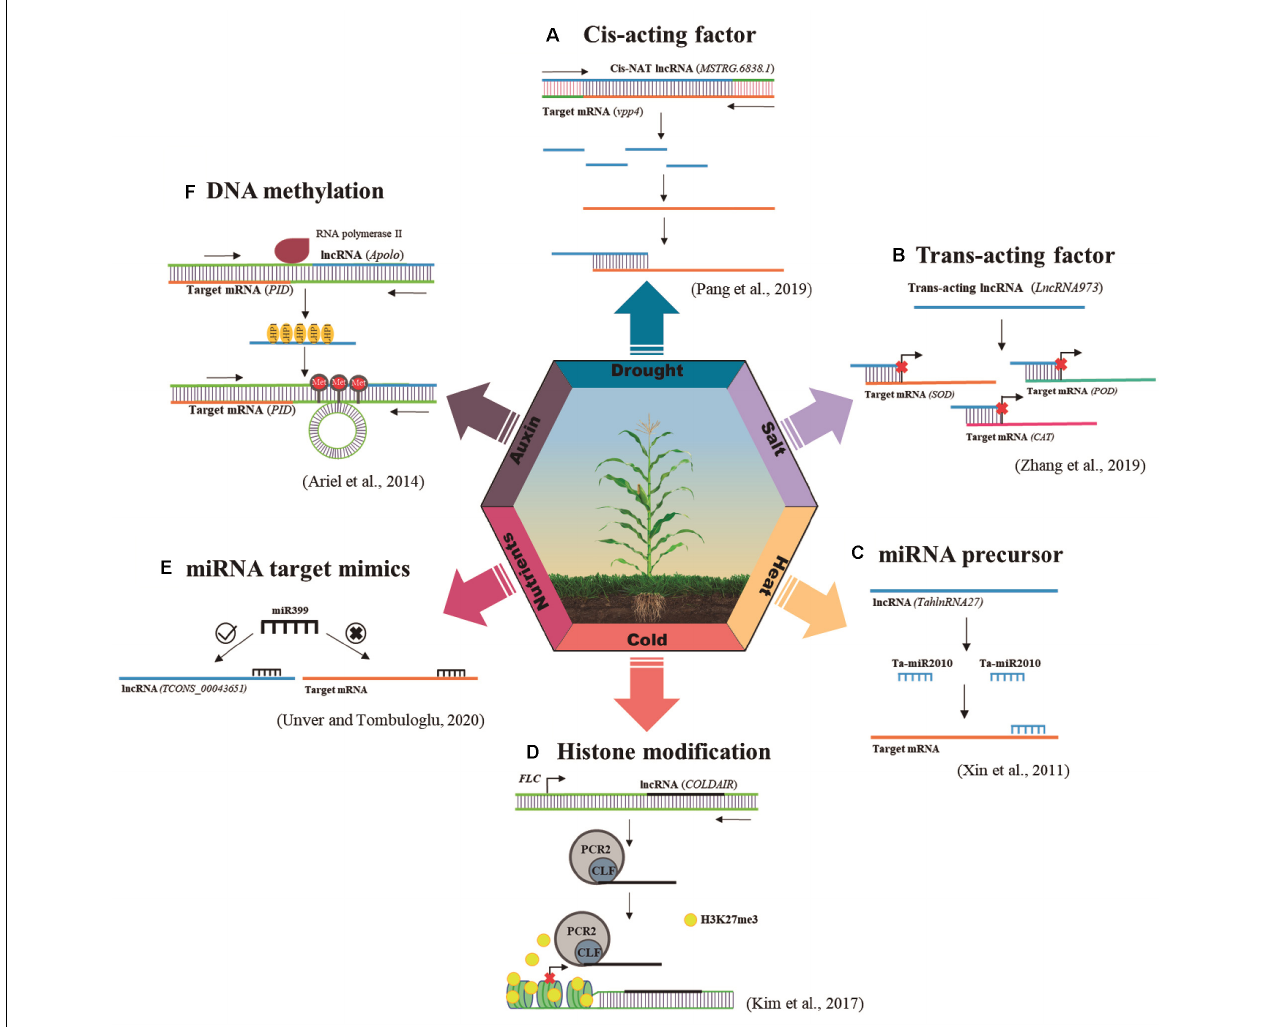
FIGURE 1 | Regulatory mechanisms of plant lncRNAs in response to abiotic stresses. The main mechanisms of action triggered by lncRNAs responsive to abiotic stresses are miRNA precursor, histone modification, target mimicry, RdDM, cis -acting factor and trans -acting factor. This figure illustrates one example of each of these mechanisms. (A) Cis -acting factor: vpp4 encoding a vacuolar (H + )-pumping ATPase subunit was identified as a putative target of an adjacent lncRNA MSTRG.6838.1 . The expressions of vpp4 and MSTRG.6838.1 were significantly correlated in many tissues and development stages, being both repressed under drought stress, which indicates that MSTRG.6838.1 and vpp4 could be a promising cis -acting pair (Pang et al., 2019). (B) Trans -acting factor: LncRNA973 corresponds to a trans -acting lncRNA responsive to salt stress, which regulates plant stress responses by modulating the expression of a series of key salt-related genes, as superoxide dismutase (SOD), peroxidase (POD), and catalase (CAT) (Zhang et al., 2019). (C) miRNA precursor: TahlnRNA27 , a heat-induced lncRNA, can act as a miRNA precursor since it presents Ta-miR2010 family sequences. After 1 h of heat-treatment, TahlnRNA27 expression was induced as well as Ta-miR2010 expression. The secondary structure and the corresponding expression pattern indicate that TahlnRNA27 might be the precursor of Ta-miR2010 (Xin et al., 2011). (D) Histone modification: The repression of FLC by vernalization is accompanied by a series of changes in histone modifications at FLC chromatin, including the deposition of repressive histone markers, such as Histone H3 Lys 27 (H3K27me3). COLDAIR is up-regulated in response to cold, physically interacting with a component of PRC2, CURLY LEAF (CLF), for the increased enrichment of PRC2 at FLC chromatin to promote H3K27me3 accumulation at FLC (Kim et al., 2017). (E) miRNA target mimics: TCONS_00043651 function as a potential natural miRNA sponge of miR399 sequence in response to boron-stress. Results obtained from barley roots analysis showed that TCONS_00043651 was up-regulated (three times than that of control) upon boron-exposure, meanwhile miR399 expression was repressed (three times down-regulated) in the same stress conditions (Unver and Tombuloglu, 2020). (F) DNA methylation: APOLO can trigger RdDM in response to an auxin stimulus. In response to auxin, Pol II APOLO transcripts gradually recruit LHP1 to mediate loop formation, whereas Pol IV/V transcription triggers DNA methylation. Then, Pol II APOLO -LHP1 mediated loop is conformed and maintained by Pol IV/V-dependent DNA methylation to repress PID expression (Ariel et al.,